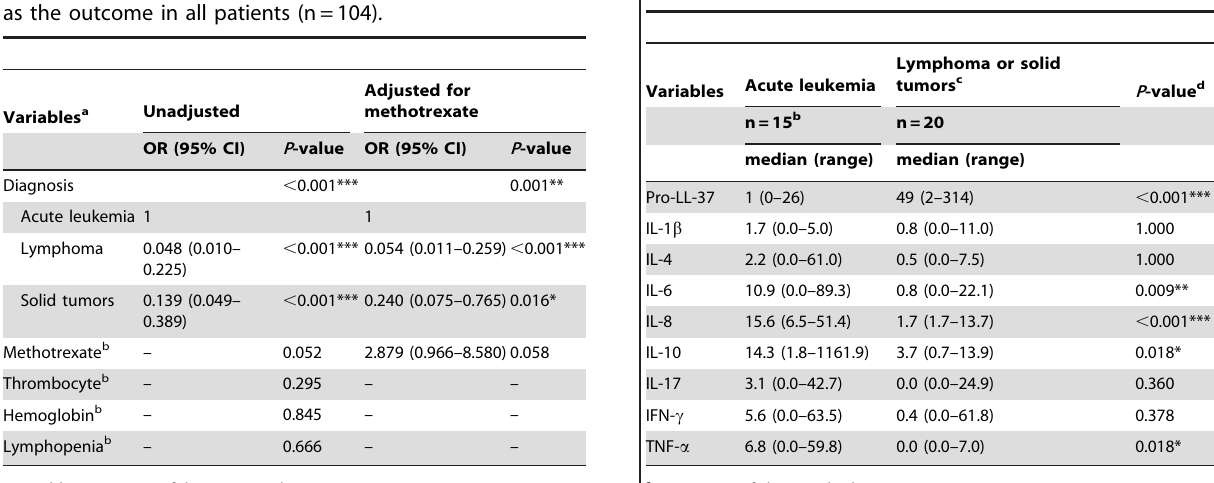
Table 5. Plasma pro-LL-37 (%) a and cytokines (pg/ml) at the time of malignancy diagnosis in patients (n=35) with different malignancy